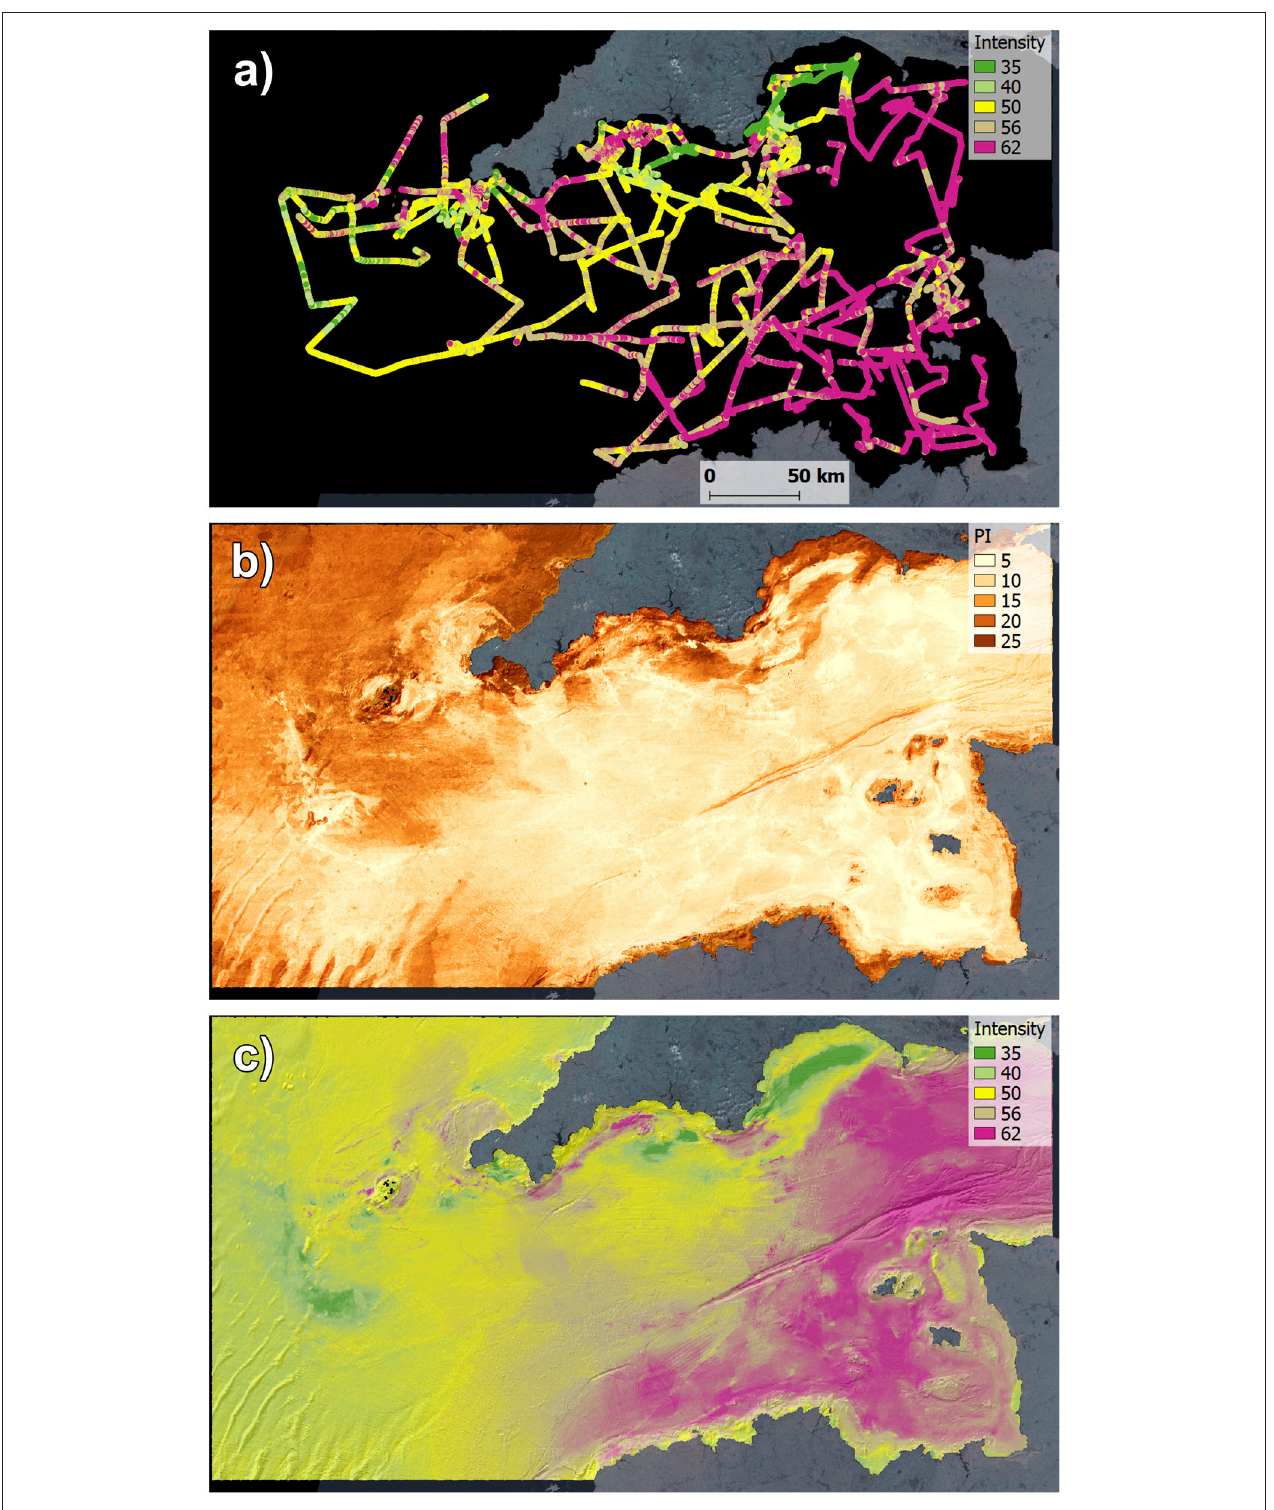
FIGURE 3 | High resolution multibeam sonar data collected opportunistically during a multi-year integrated ecosystem survey program (van der Kooij et al., 2011; ICES, 2015). (A) spatial plot of survey lines showing strength of returned acoustic signal (backscatter intensity, dB) revealing changes in the physical properties of the seabed; (B) prediction interval (PI) of modeled seabed acoustic intensity return using random forest regression on broadscale auxiliary environmental variables (e.g., Mascaro et al., 2014), areas with high prediction interval show greater variance and require higher resolution data or additional variables to reduce the uncertainty; (C) final modeled seabed acoustic intensity (dB) return map, revealing broadscale variability in the physical conditions and facilitating better planning of future survey activity. Frontiers in Marine Science |